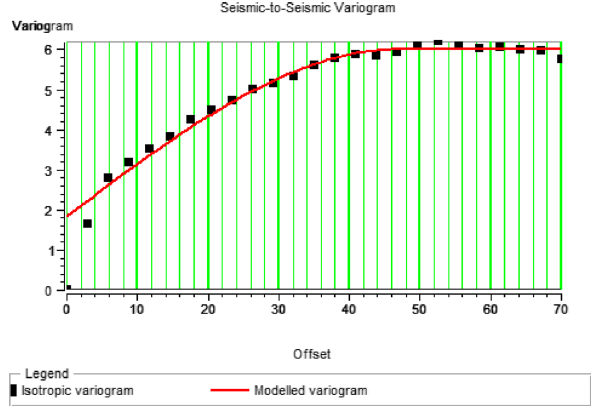
Fig. 34 The structure of the second seismic attributes